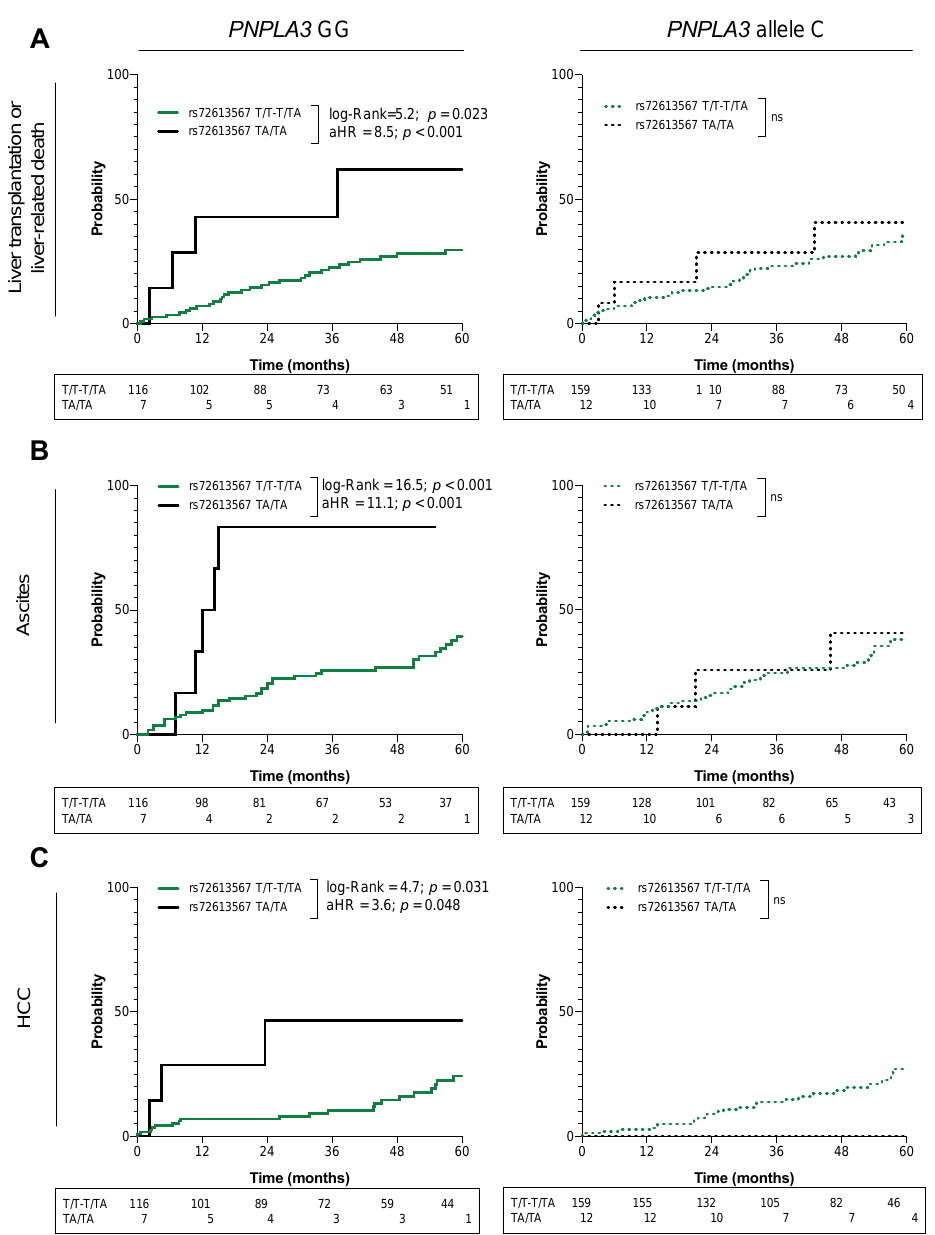
Figure 3. Effect of the PNPLA3 rs738409 GG genotype on the risk of ( A ) liver-related mortality, ( B ) ascites, and ( C ) hepatocellular carcinoma, according to the HSD17B13 rs72613567 genotype. aHR: adjusted hazard ratio; ns: not significant p